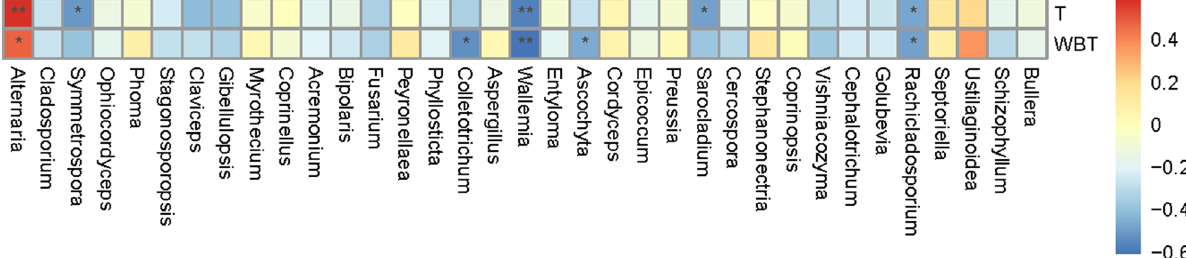
Figure 12. Heat map of correlation with environmental factors at the level of genus.